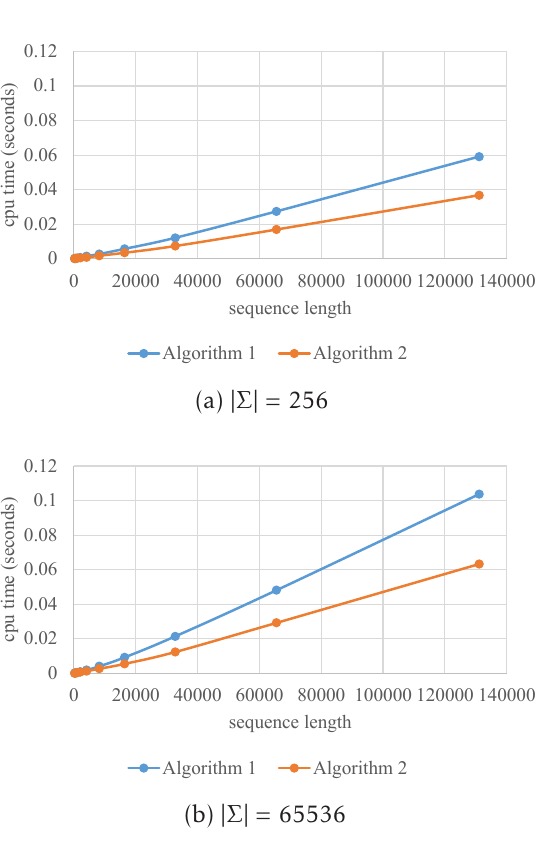
Figure 3. Average CPU time for Strings of characters from varying size alphabets.